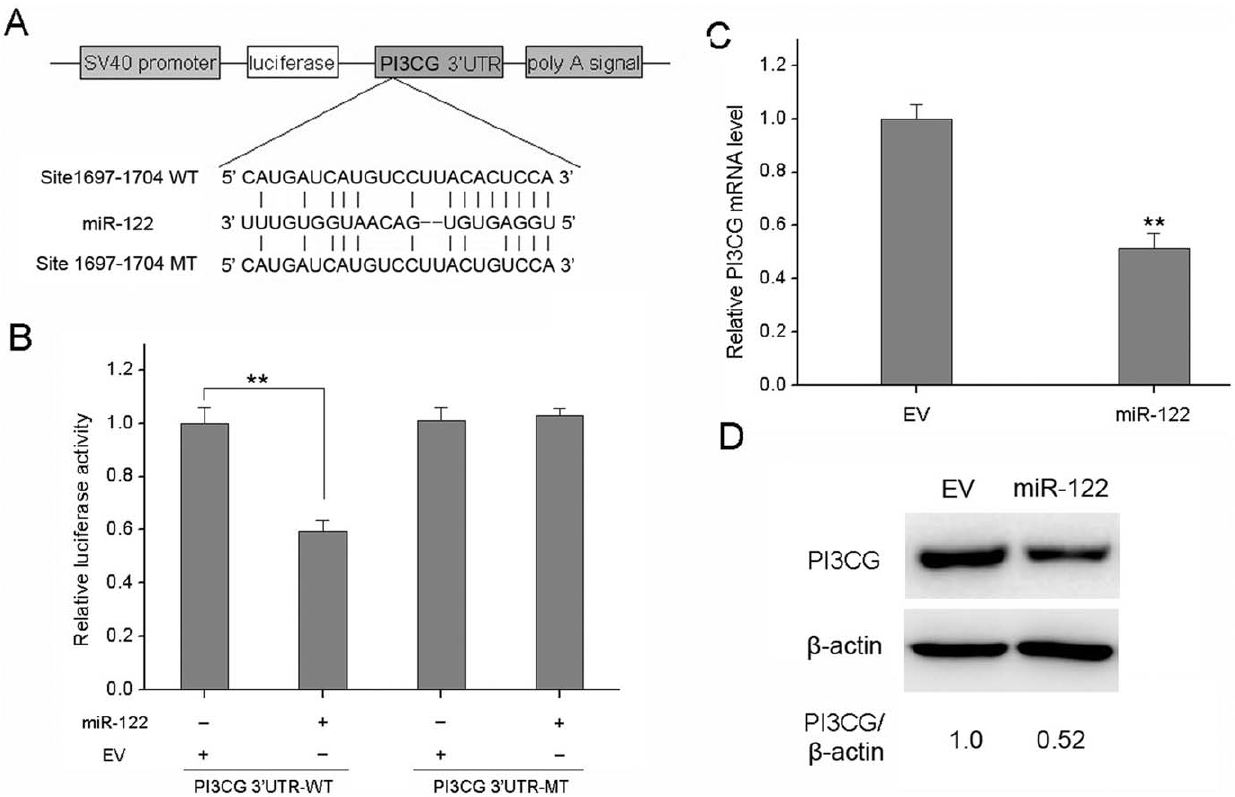
Figure 6. miR-122 down-regulates PI3CG expression by directly binding to its mRNA 3 9 UTR. (A) PI3CG 3 9 UTR and PI3CG 3 9 UTR-MT were inserted into the region immediately downstream of the luciferase gene in pGL3 vector. (B) Dual luciferase reporter assays were performed. The expression of the reporter containing PI3CG 3 9 UTR was suppressed by miR-122, but not in the mutated construct. qRT–PCR (C) and Western blot (D) analyses were performed to examine the effects of miR-122 on PI3CG expression in MCF-7 cells. All experiments were carried 3 times independently. *P , 0.05 compared to EV group. **P , 0.01 compared to EV group.